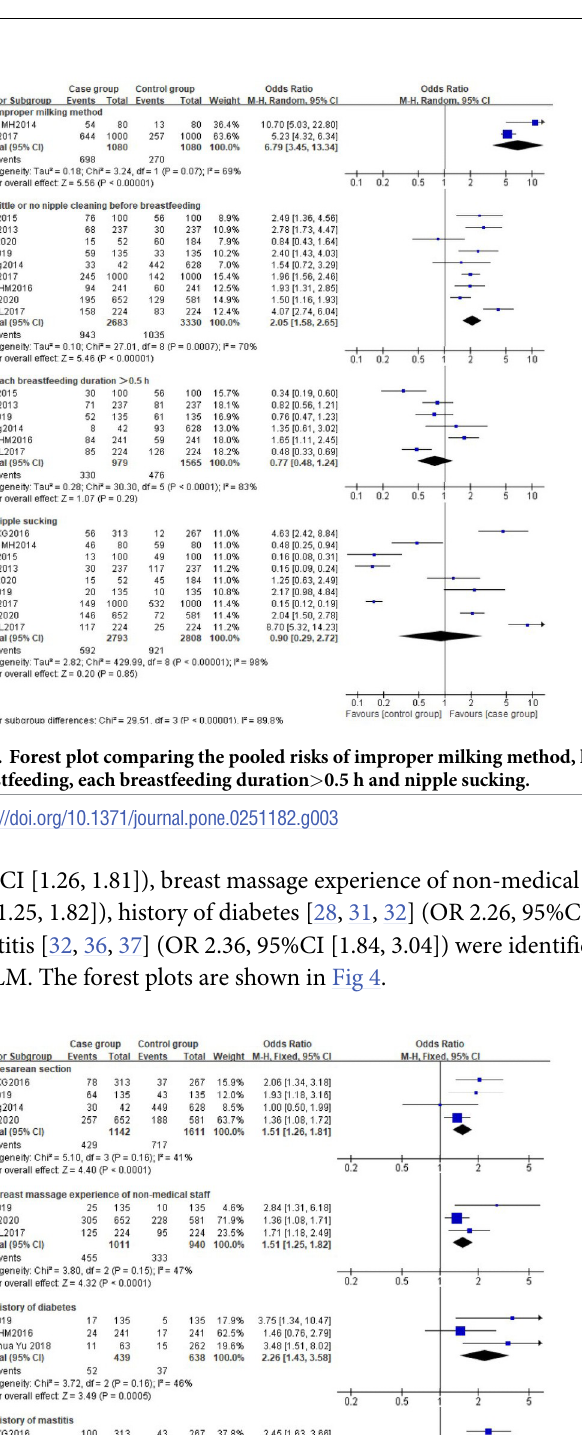
PLOS ONE | https://doi.org/10.1371/journal.pone.0251182 May 13,